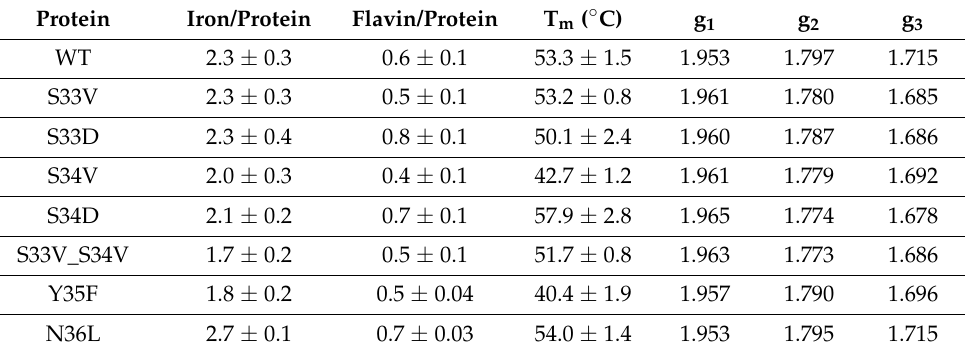
Table 1. Ratios of iron/FMN/protein; melting temperatures (Tm, ◦ C), determined by circular dichroism; and g-values for the Electron Paramagnetic Resonance (EPR) signals of the diiron center in the mixed valence state, obtained by theoretically simulating the spectra using SPINCOUNT [29], for wt FlRd and mutants.